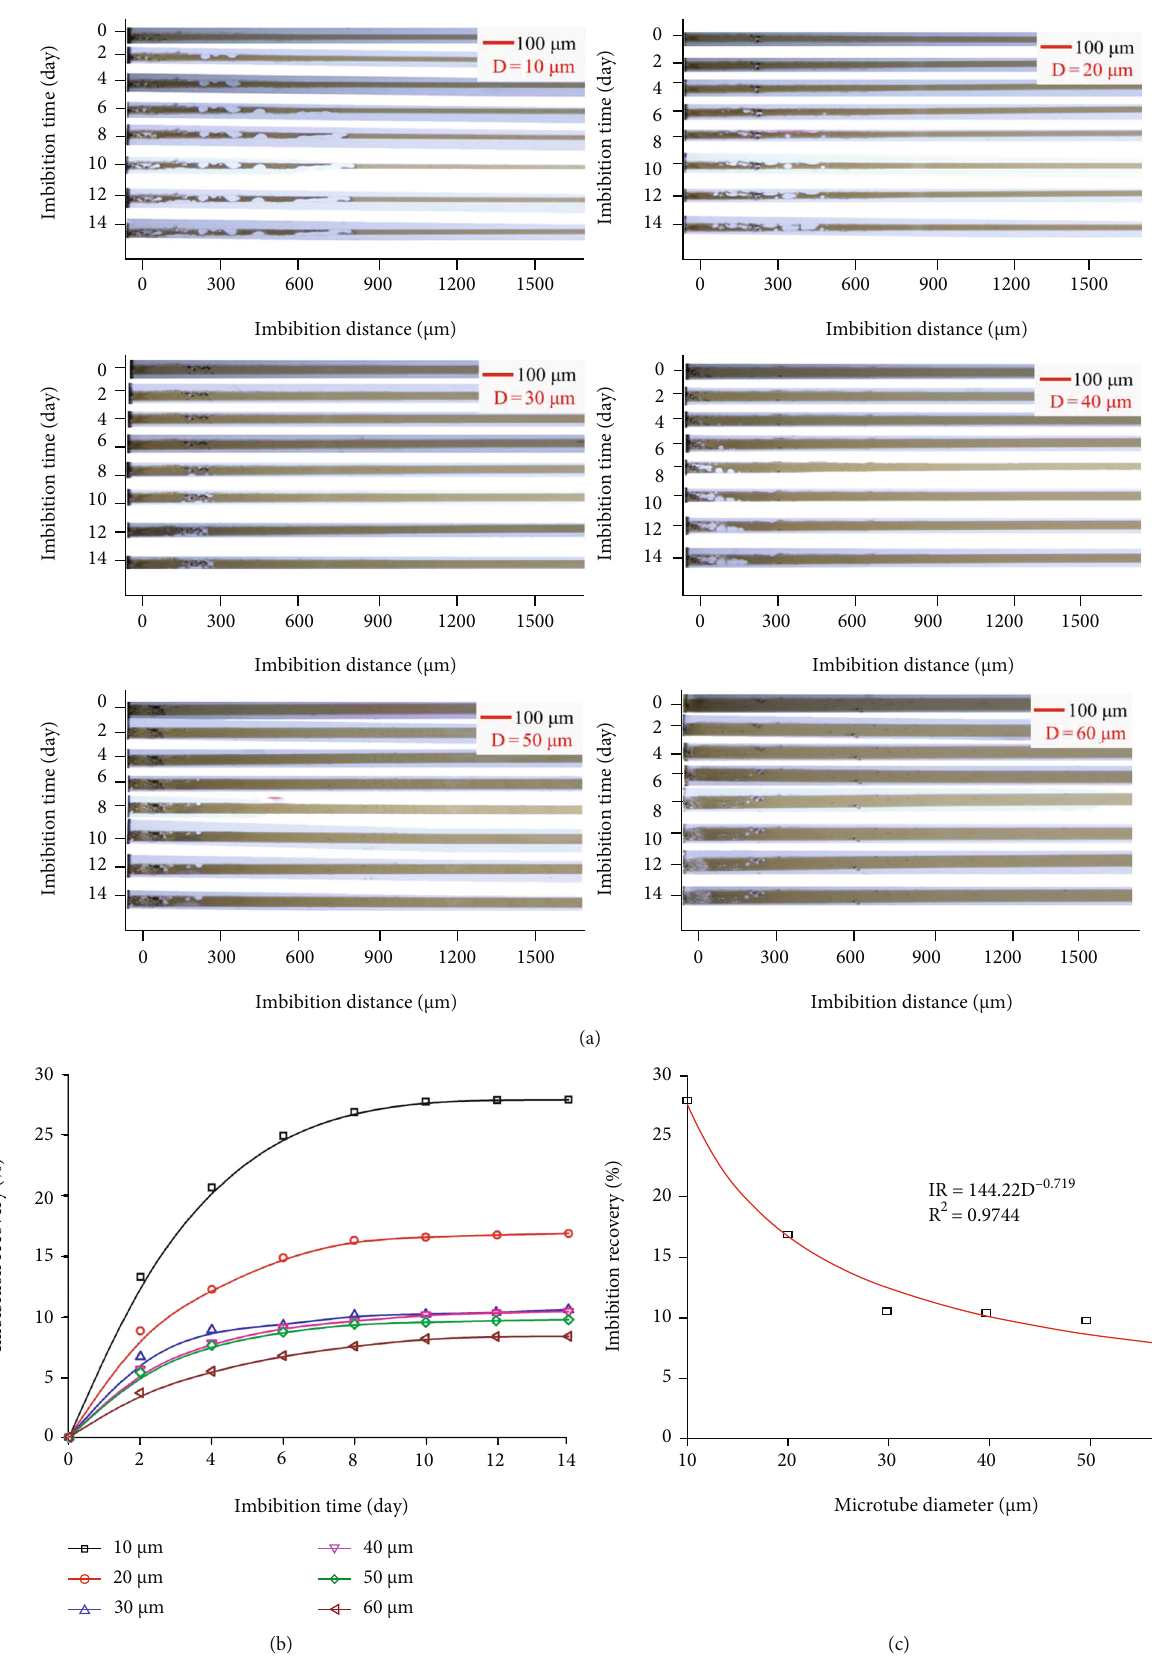
Figure 3: (a) Spontaneous imbibition results in the oil capillaries with six di ff erent diameters. (b) Results of imbibition time versus with imbibition recovery in six di ff erent diameter capillaries. (c) Relationship between microtube diameter and imbibition